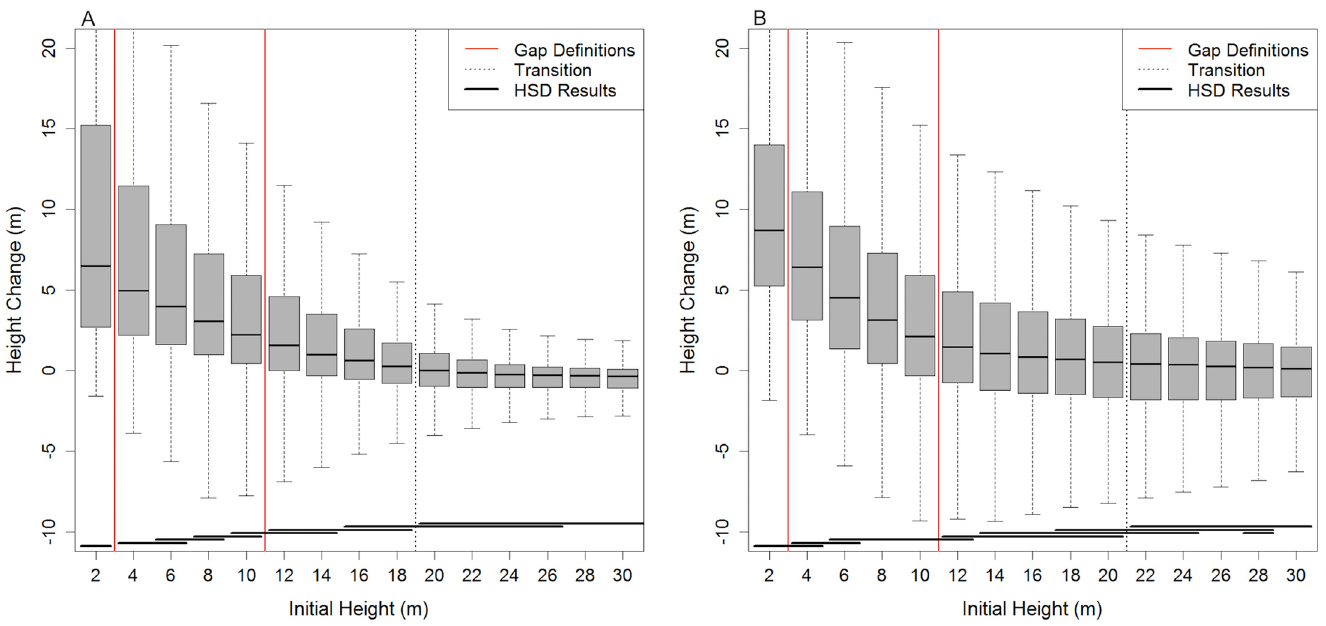
Fig 2. Mean and confidence interval of height change between initial and final lidar data acquisitions. Data collected at (a) Ducke Reserve and (b) Tapajos National Forest overlaid with the Brokaw (1982) and dynamic gap definitions ’ height cutoffs, and the transition height where height change is not significantly different from zero based on Tukey ’ s HSD (horizontal segments at the base of the figure). Each horizontal line displaying Tukey ’ s HSD results spans initial height bins for which there is no significant difference (p-value >